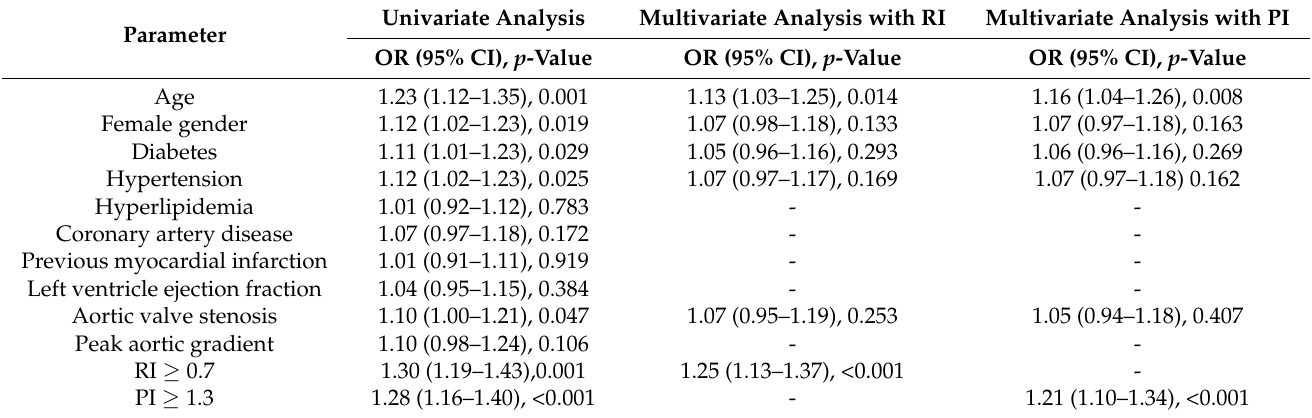
Table 3. Univariate and multivariate logistic regression analysis of factors associated with heart failure episodes (HF) and major adverse cardiac and cerebral events